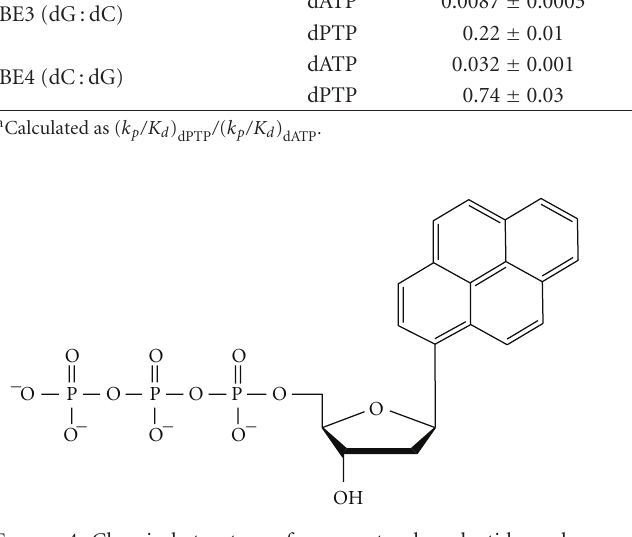
Figure 4: Chemical structure of a nonnatural nucleotide analog,